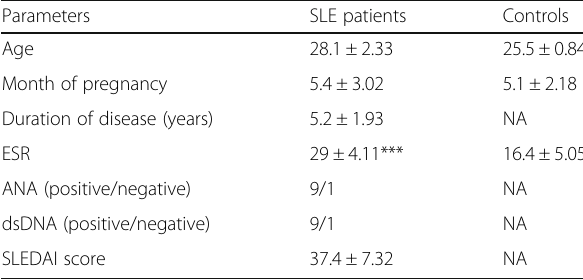
Table 1 Demographic characteristics of pregnant SLE patients and pregnant healthy